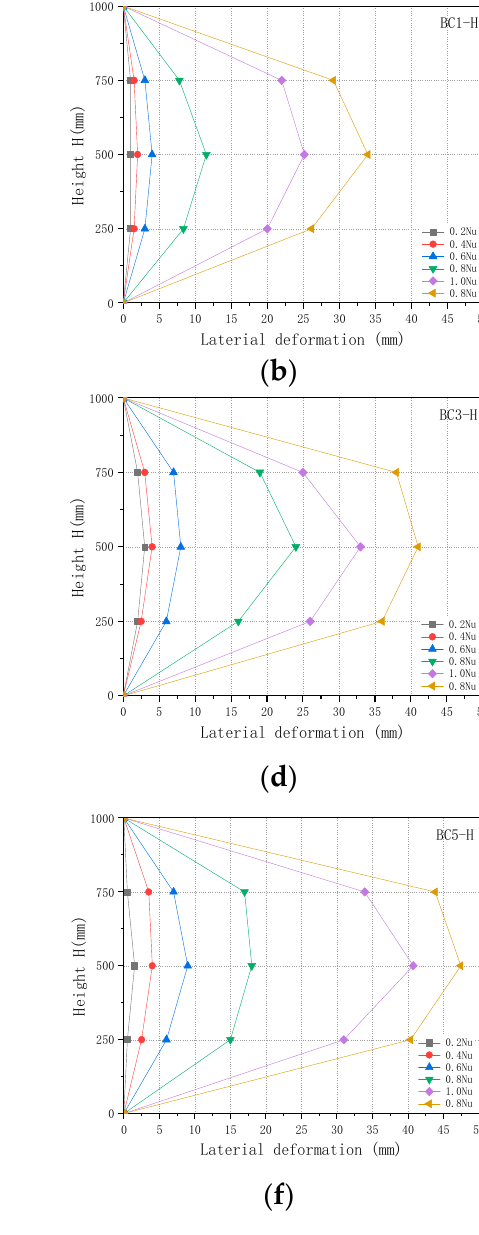
Figure 9. Lateral deformation vs. height with different loads: ( a ) BC0-H; ( b )BC1-H; ( c ) BC2-H; ( d ) BC3-H; ( e ) BC4-H; ( f ) BC5-H.